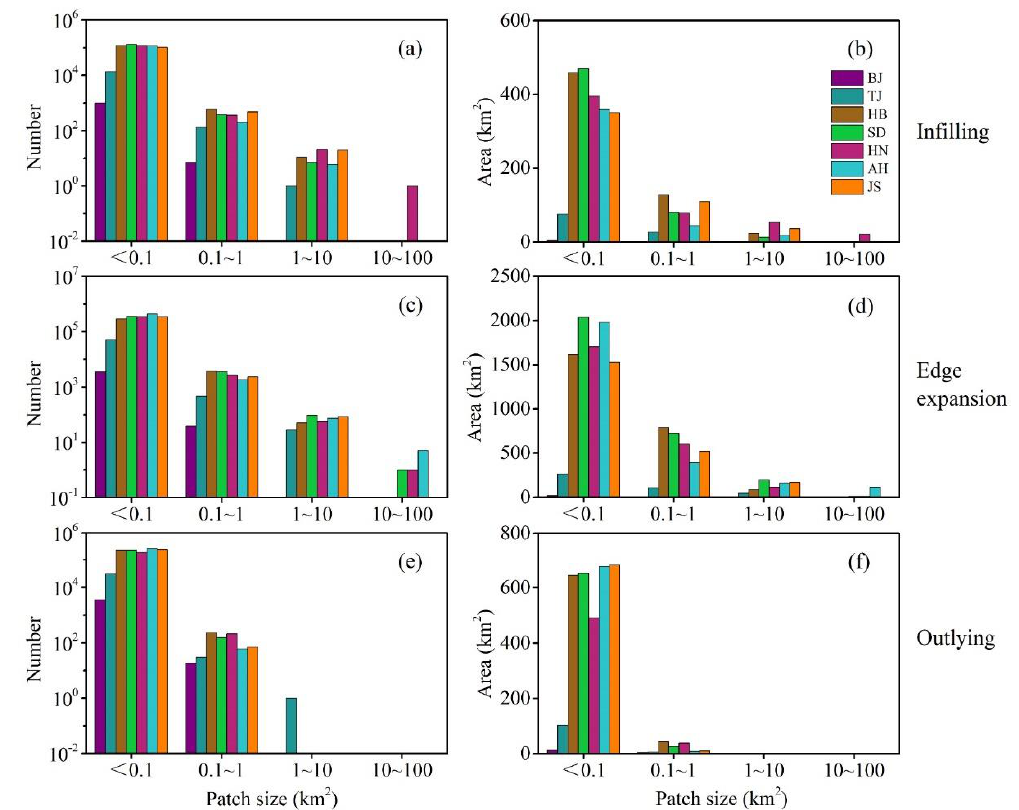
Figure 12. The number ( a , c , e ) and area ( b , d , f ) distributions of BLF patches with different patch sizes under three expansion types in 1975–2014. Legend abbreviations: BJ, Beijing; TJ, Tianjin; HB, Hebei; SD, Shandong; HN, Henan; AH, Anhui; and JS, Jiangsu. Table 4. Pearson correlation coe ffi cients between the patch sizes of built-up land in floodplains and flood occurrence in the North China Plain